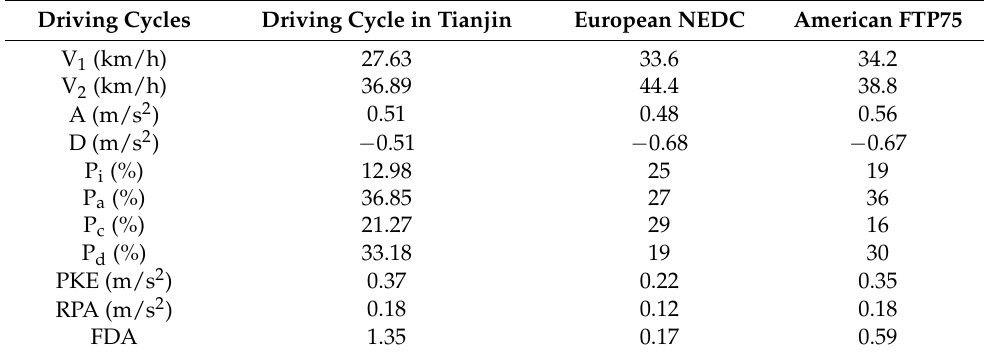
Table 4. The comparison of vehicle driving characteristic parameters between Tianjin and Europe and the US.